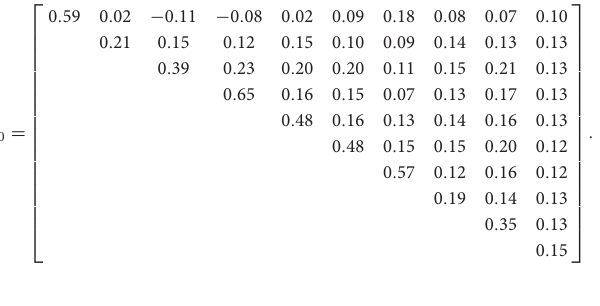
TABLE 4 | Accuracies of direct and maternal (G)EBV and correlations between direct and maternal (G)EBV for validation animals from the complete and reduced datasets using various models with and without genetic groups.